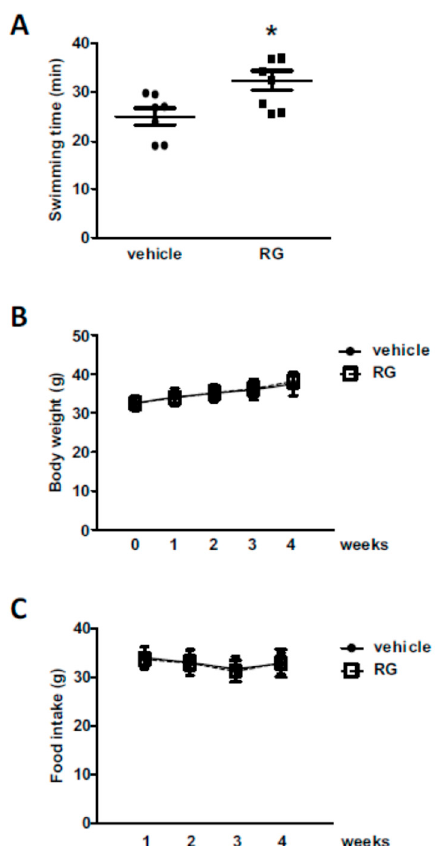
Figure 1. Effects of red ginseng (RG) on exhaustive swimming time. Mice were fed with vehicle or 100 mg/kg RG for 28 days, and ( A ) exhaustive swimming test was performed. Exhaustive swimming time was recorded as the time when each mouse was unable to return to the surface to breathe within 7 seconds. ( B ) Bodyweight and ( C ) food intake were measured. Data were expressed as mean ± S.E. (n = 8). * p < 0.05 versus vehicle group.